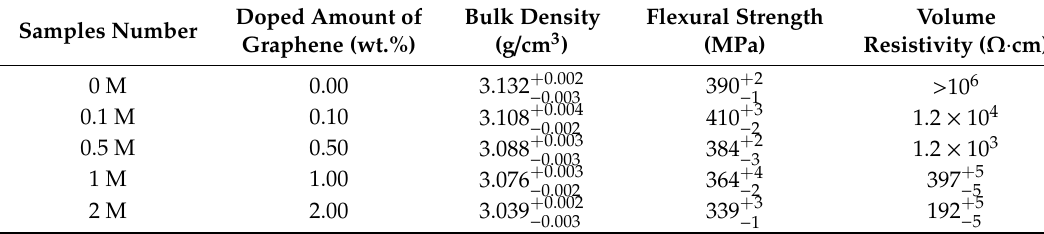
Table 1. Effects of graphene doping on SiC ceramics.